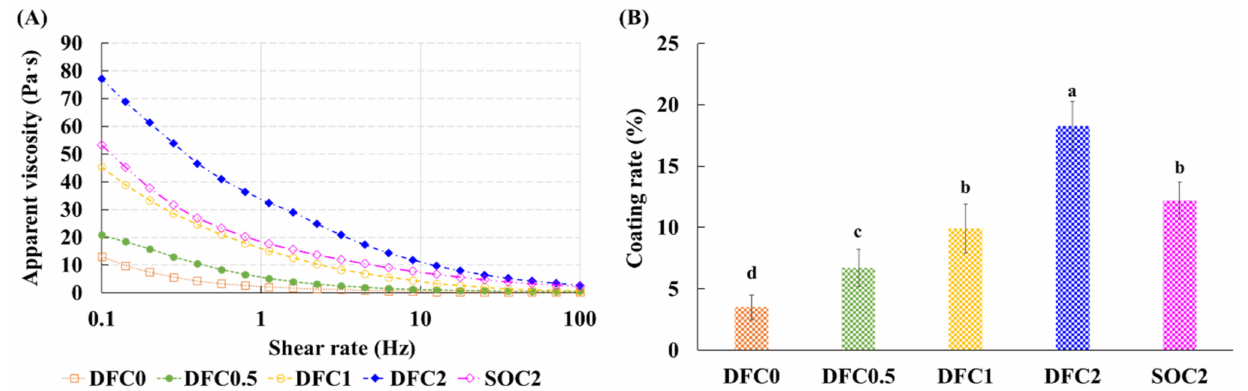
Figure 1. Apparent viscosity and coating rate of the coating solution. ( A ) Apparent viscosity ( n = 3) and ( B ) coating rate ( n = 3). DFC0, coated with duck fat, with no chitosan; DFC0.5, coated with duck fat and 0.5% chitosan; DFC1, coated with duck fat and 1% chitosan; DFC2, coated with duck fat and 2% chitosan; SOC2, coated with soybean oil and 2% chitosan. Bars with the different letter are significantly different ( p < 0.05), and the error bars indicate